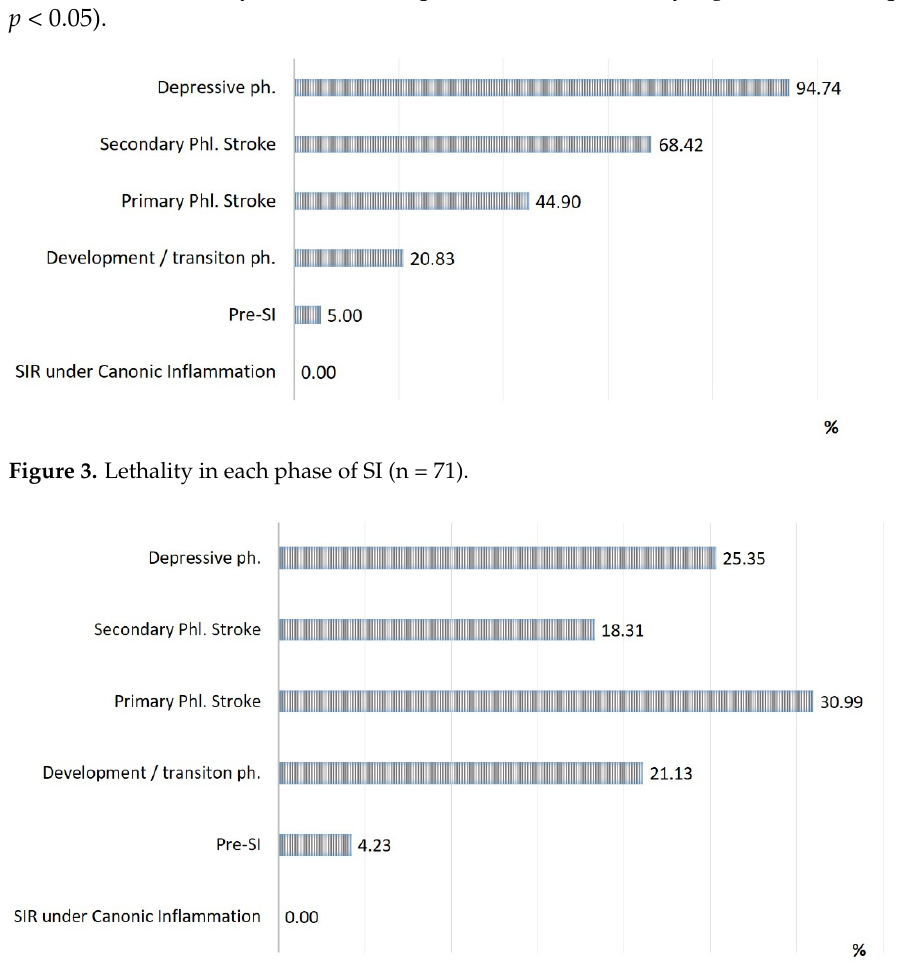
Figure 4. Distribution of all lethal cases by SI phases (n = 71).